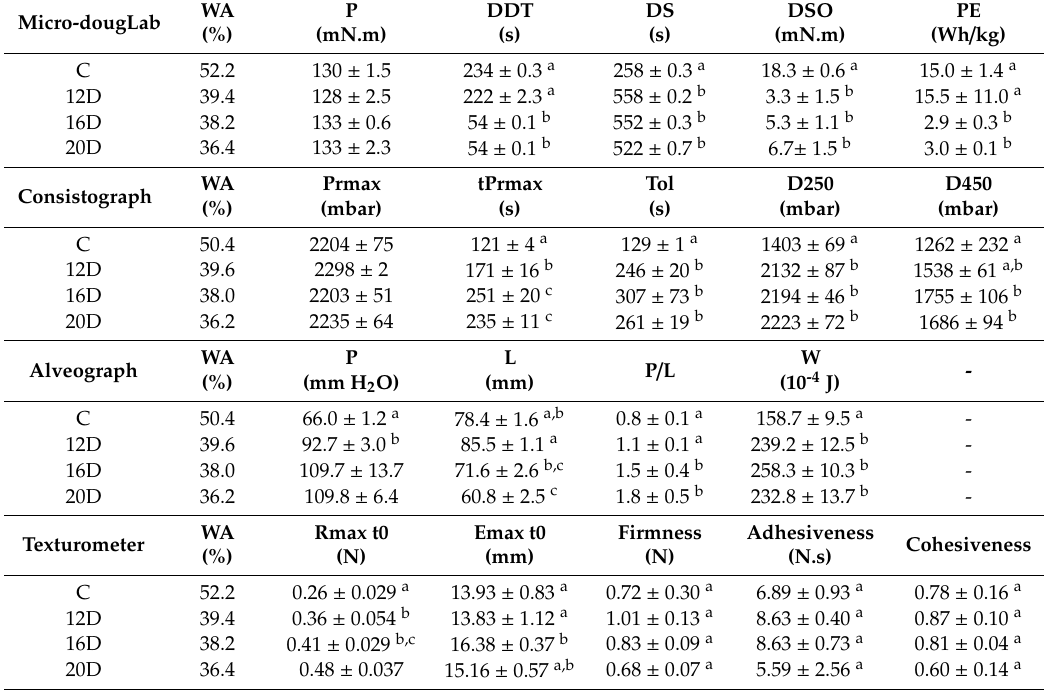
Table 2. Rheology parameters * obtained from Micro-doughLab mixture curves, Consistograph, Alveograph and Texturometer (Texture Profile Analysis and Extensibility tests). C: control dough without whey; 12D: dough with 12% whey; 16D: dough with 16% whey; 20D: dough with 20% whey. For each equipment, di ff erent letters (a, b, c) in the same column correspond to significant di ff erences (one-way ANOVA, p <